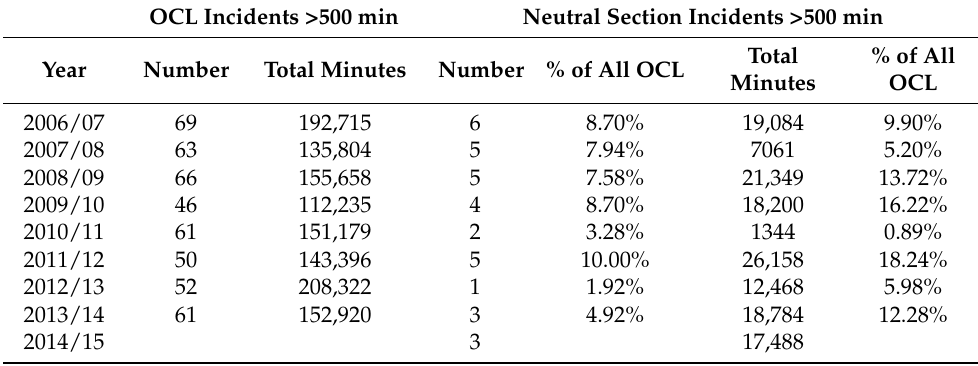
Table 1. Number of OCL and neutral section incidents causing train delays >500 min, showing disproportionate impact